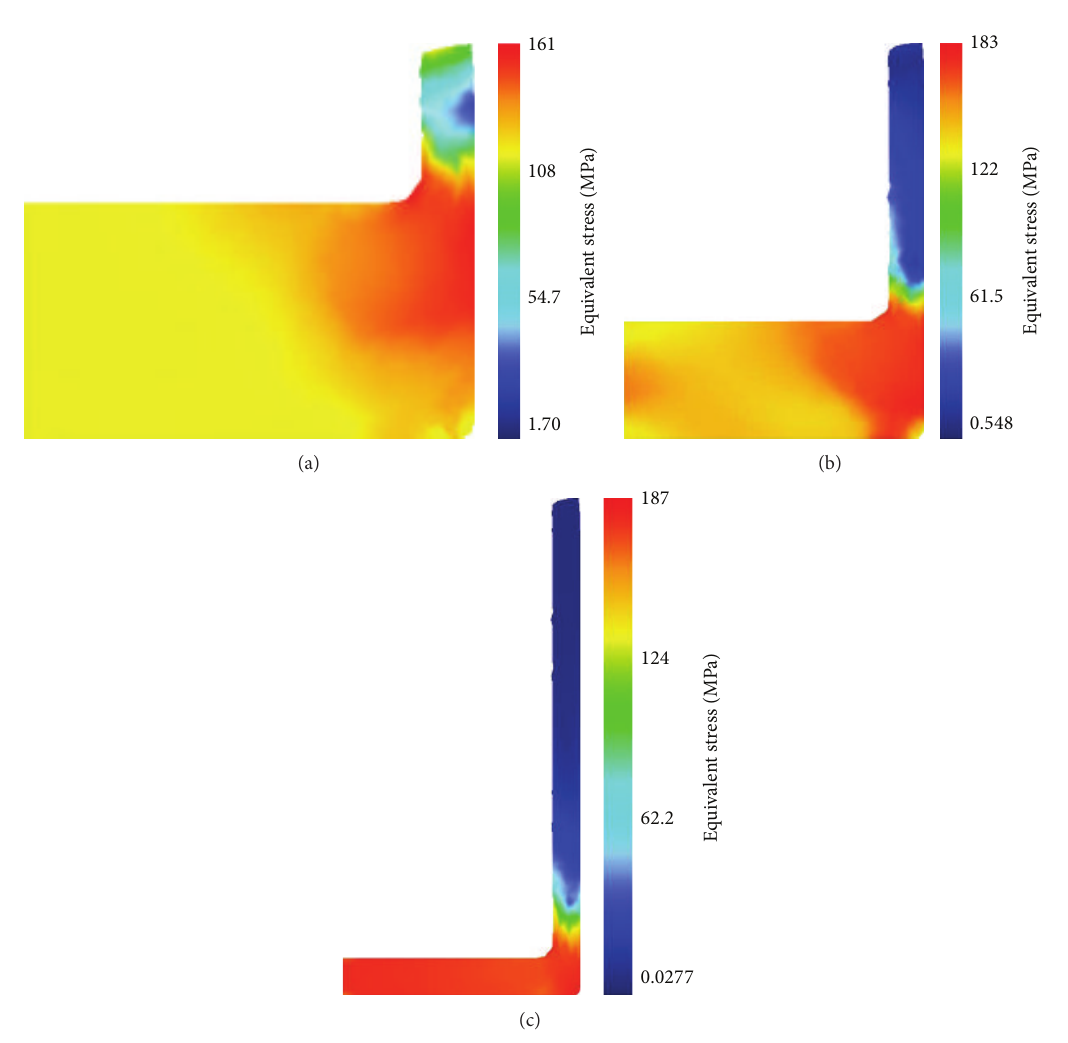
Figure 6: Equivalent stress contours with different deformation: (a) Δ h = 5 mm; (b) Δ h = 10mm; (c) Δ h = 20